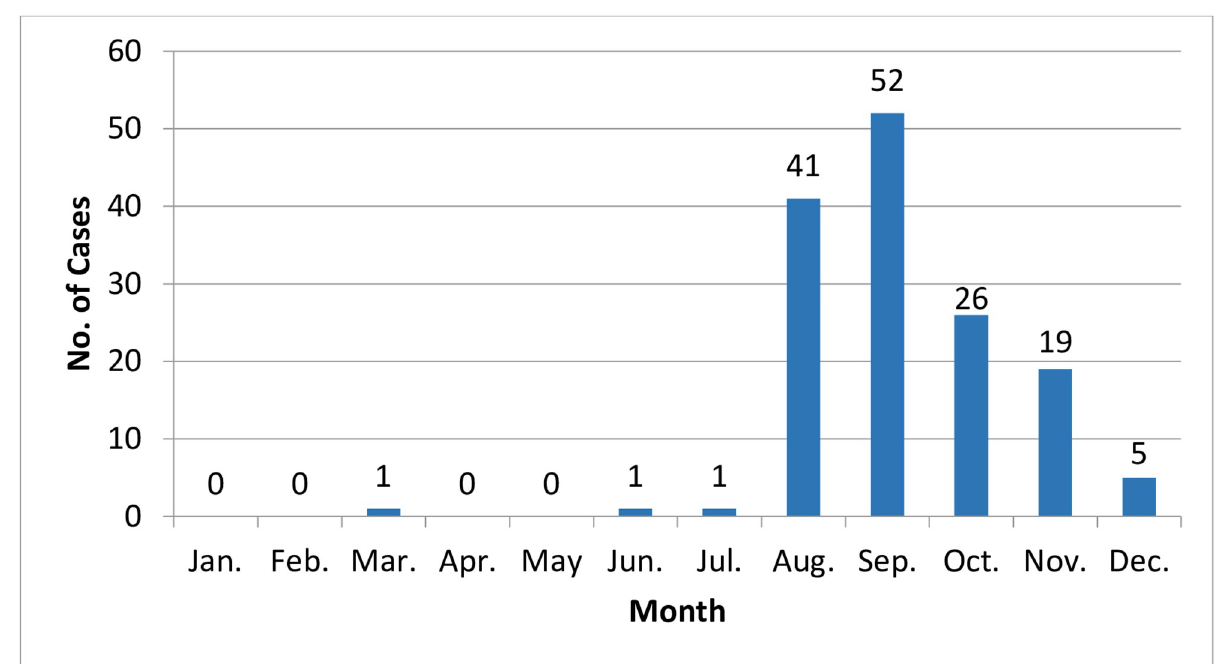
Fig 3. Cryptosporidium cases in Haifa and West Galilee per month during